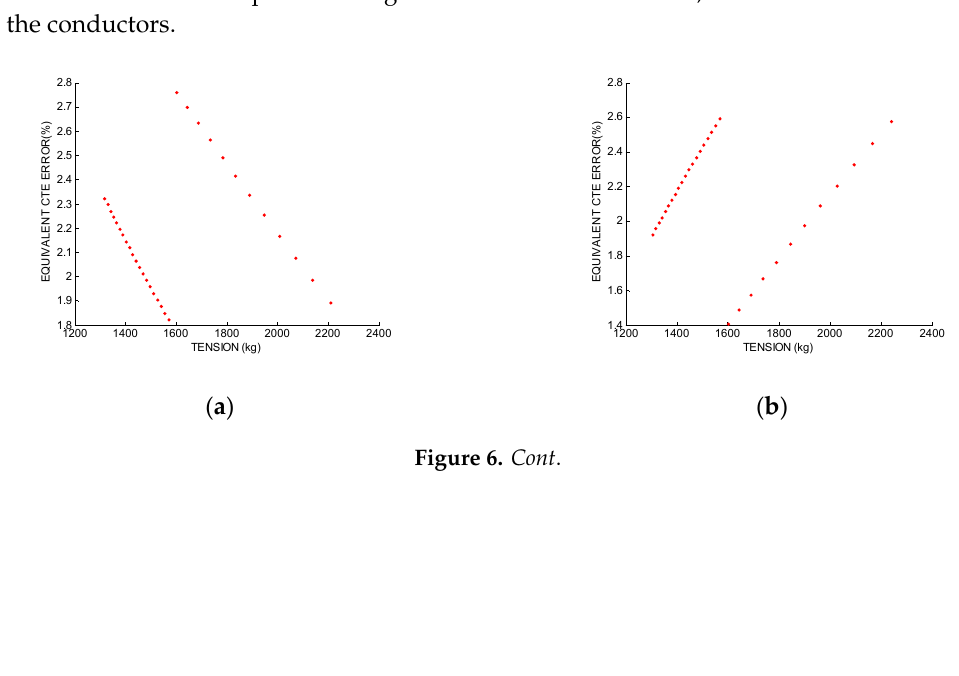
Figure 5. Equivalent coefficients of thermal expansion (CTE) error. ( a ) 2% weight error; ( b ) 5% modulus of elasticity error; ( c ) 1% span length error; ( d ) 2% insulating string length.